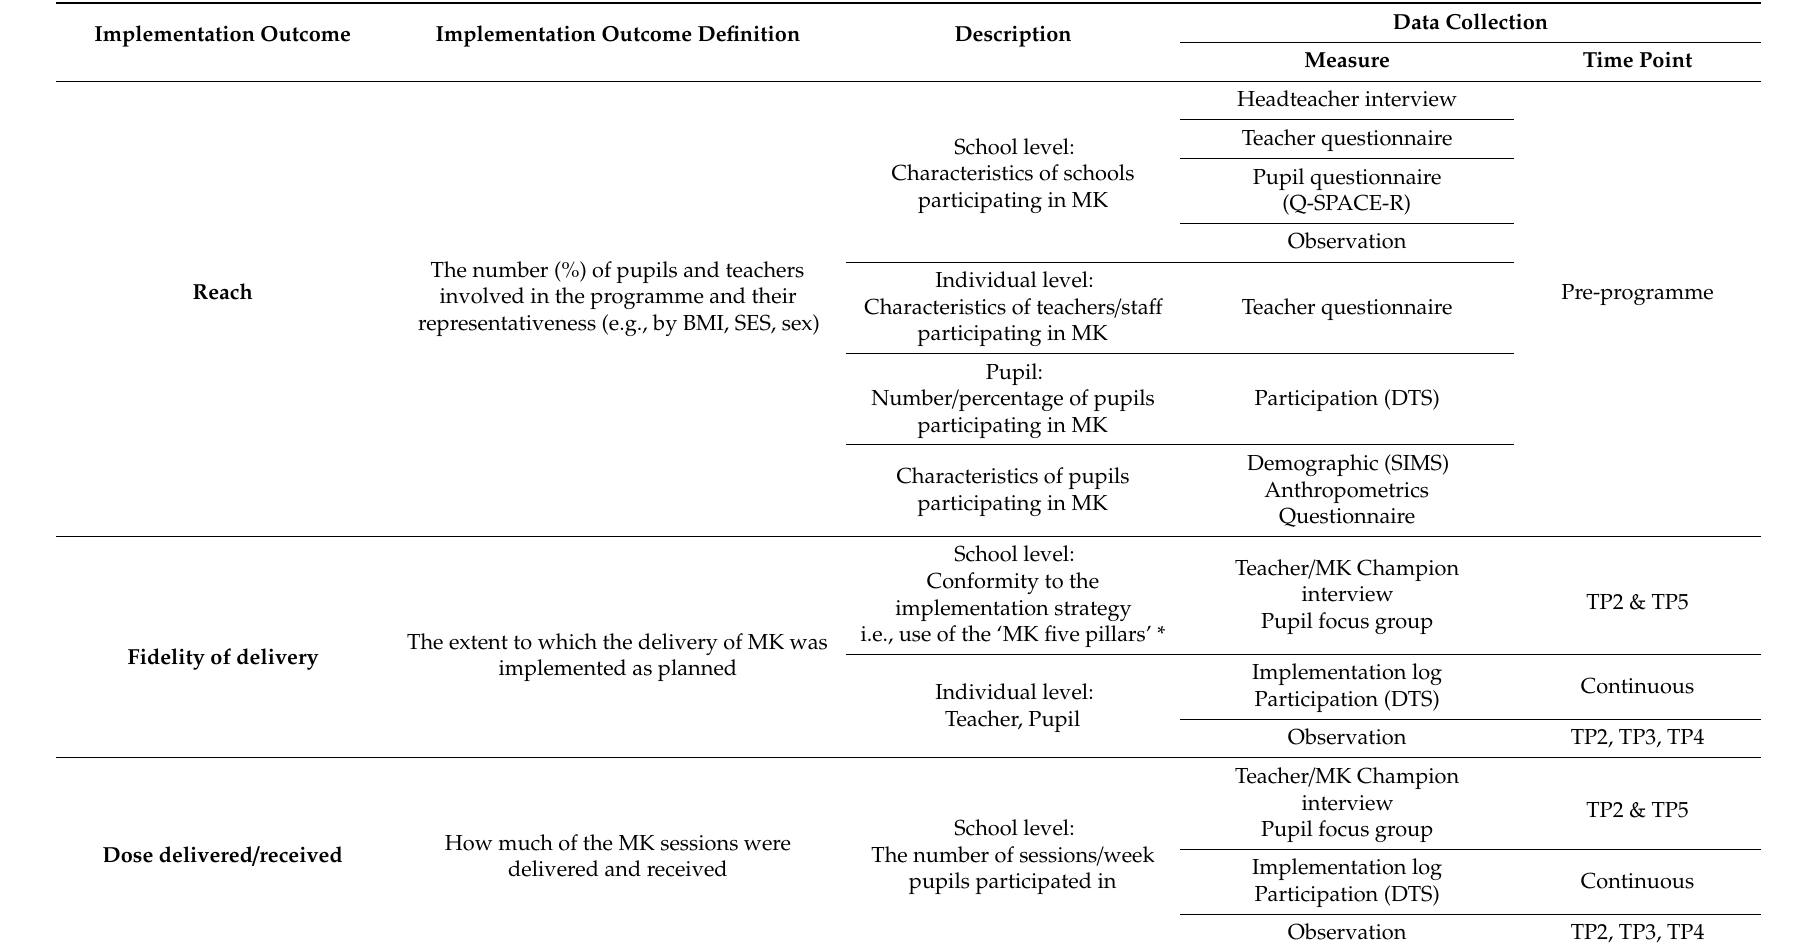
Table 1. A summary of the implementation evaluation measures